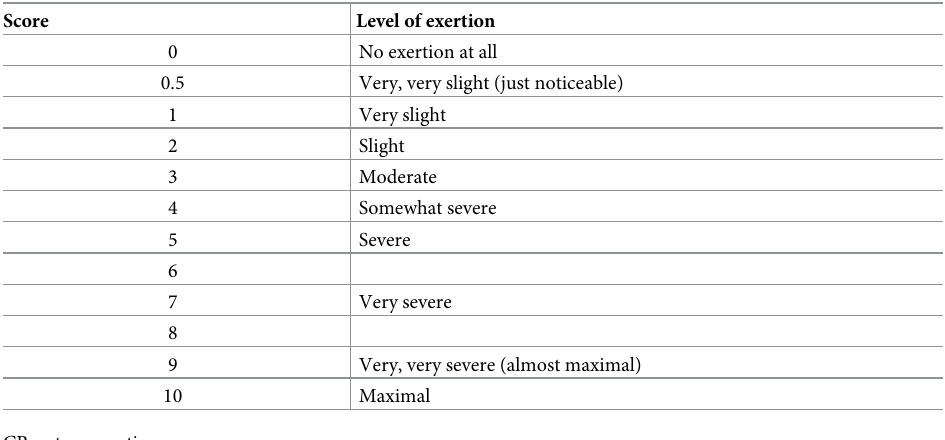
Table 1. The Borg CR10 scale